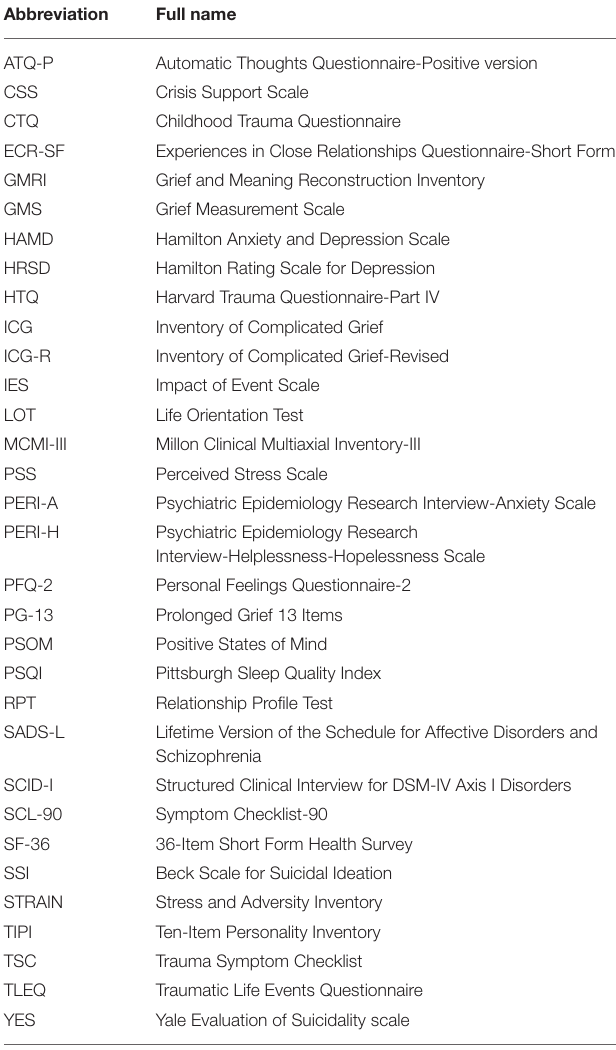
TABLE 1 | Assessment instruments used in the studies